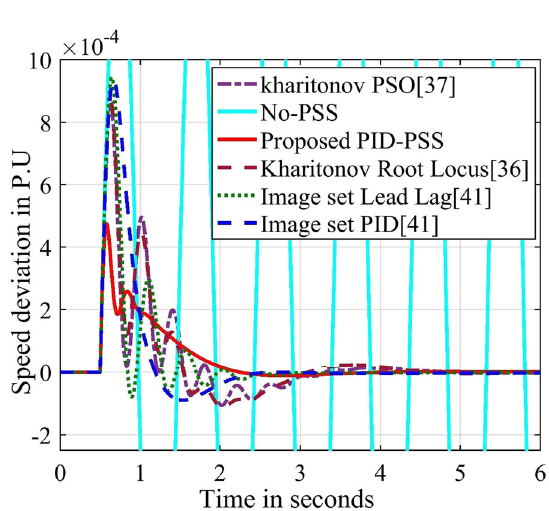
Fig. 17 Comparison of speed deviation response of the proposed with existing methods to 0.1 p.u. . torque disturbance at P = 1.2 p.u. and Q = 0.2p.u